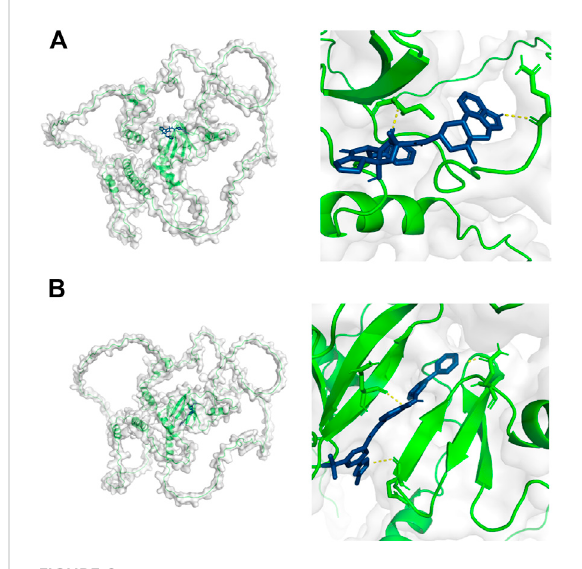
FIGURE 8 Molecular docking results of YAP1 with ZINC000003978005 (A) andZINC000006716957 (B) .Greencolor represents the structure of YAP1 protein, the blue color represents the structure of small molecules, and the yellow color represents the hydrogen bonds between the YAP1 protein and small